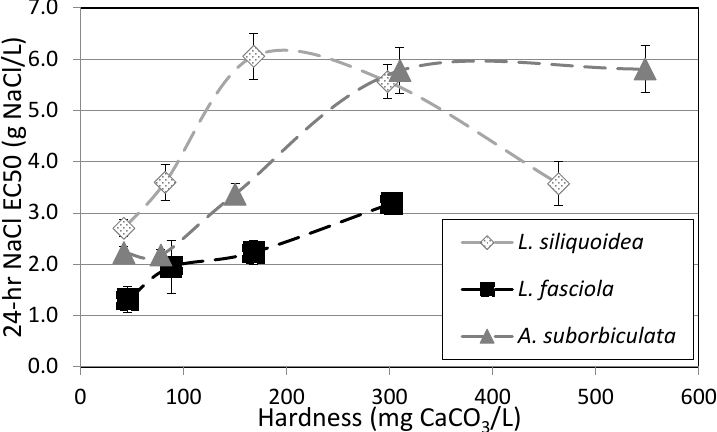
Figure 4. Effect of water hardness on 24 hr NaCl EC50s for glochidia from Lampsilis siliquoidea, L. Fasciola, and Anodonta suborbiculata . Error bars represent the upper and lower 95% confidence limits. Dashed lines indicate general trends and are not fitted regression lines.